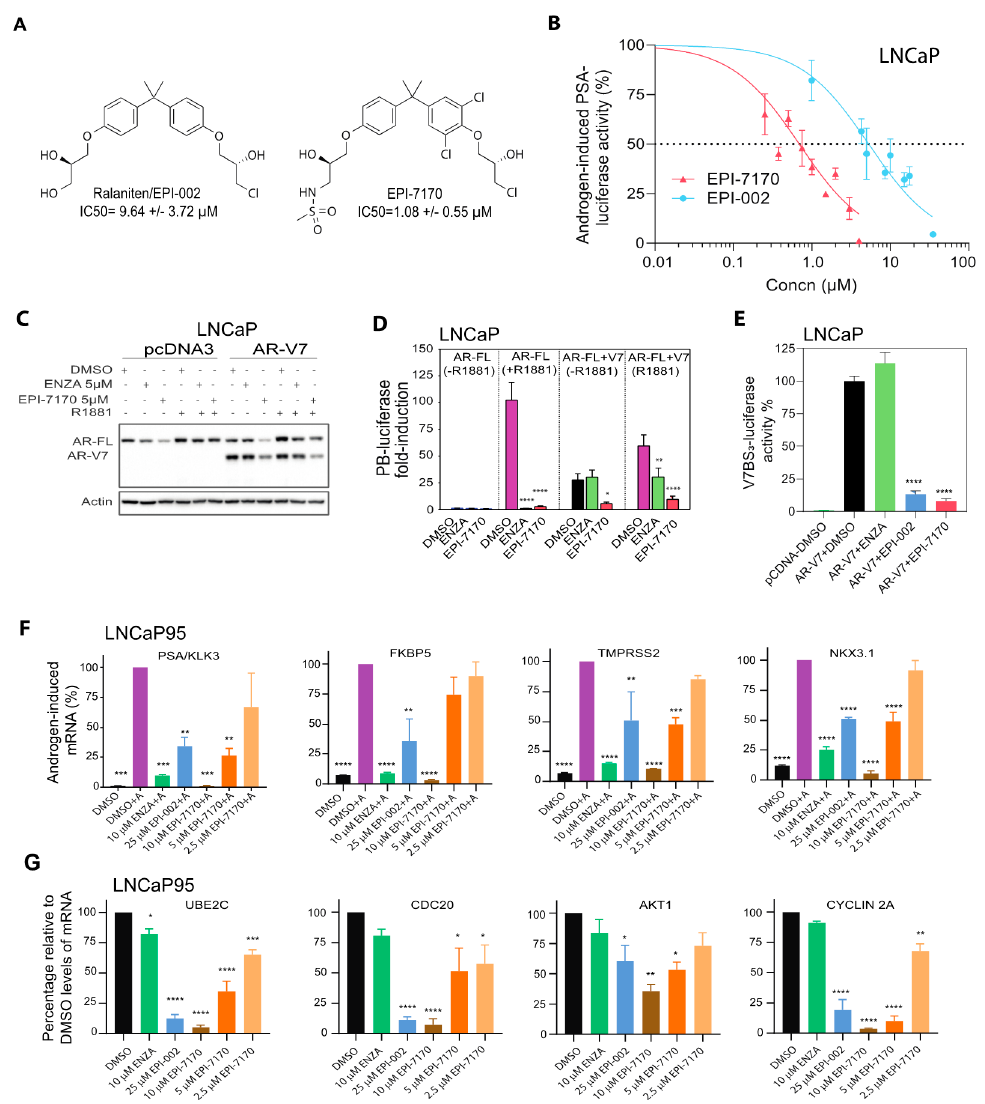
Figure 1. EPI-7170 is a next-generation ralaniten analog that has improved potency against the transcriptional activities of both full-length androgen receptor (AR) and active splice variants of AR (AR-Vs). ( A ) Chemical structures for ralaniten (EPI-002) and next-generation analog EPI-7170. IC50s values are for inhibition of androgen-induced PSA(6.1kb)-luciferase activity in transiently transfected LNCaP cells. ( B ) Dose-dependent inhibition of androgen-induced PSA(6.1kb)-luciferase activity in LNCaP cells. Cells were pretreated with EPI-002 and EPI-7170 before the addition of synthetic androgen R1881 (1 nM). Luciferase activities were normalized to total protein. ( C ) Levels of ectopic AR-V7 protein relative to endogenous full-length AR in LNCaP cells. Cells were transiently